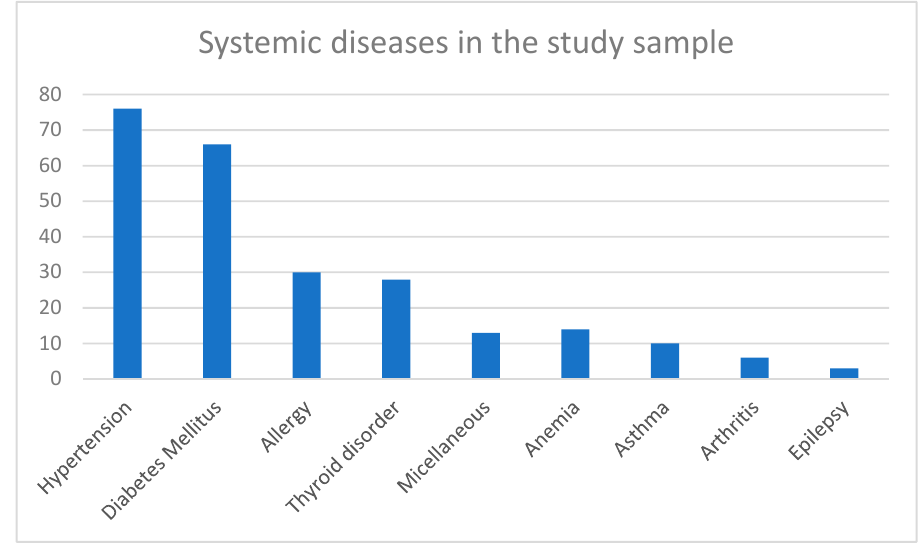
Figure 1. Frequency of systemic diseases in the study sample. Table 1. Comparison between patient groups with dental diseases (caries, retained roots -RR, and